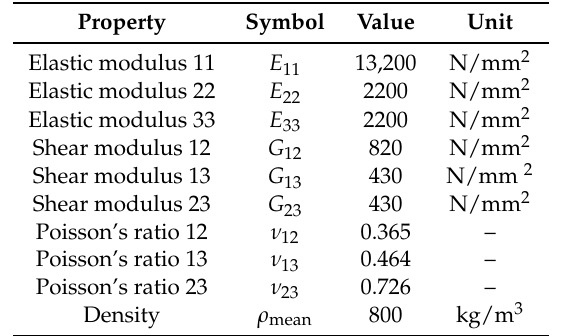
Table 1. Elastic properties used for orthotropic material model of 40 mm thick BauBuche Q panels. Reprinted from [26], Copyright (2019), with permission from